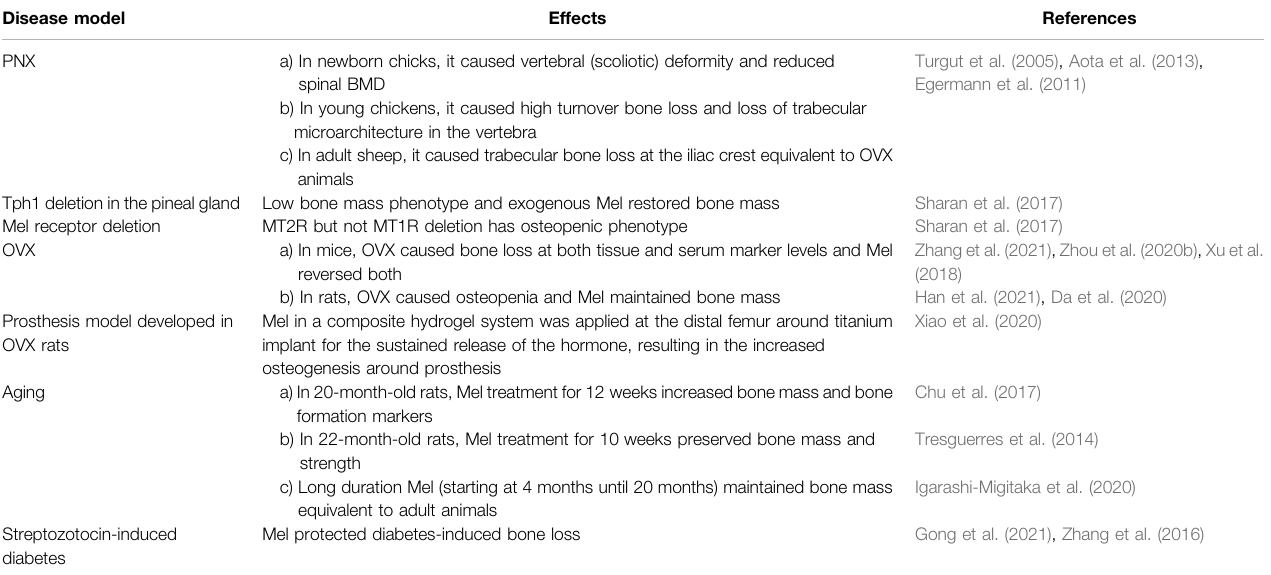
TABLE 2 | Skeletal effects of Mel in preclinical models of bone